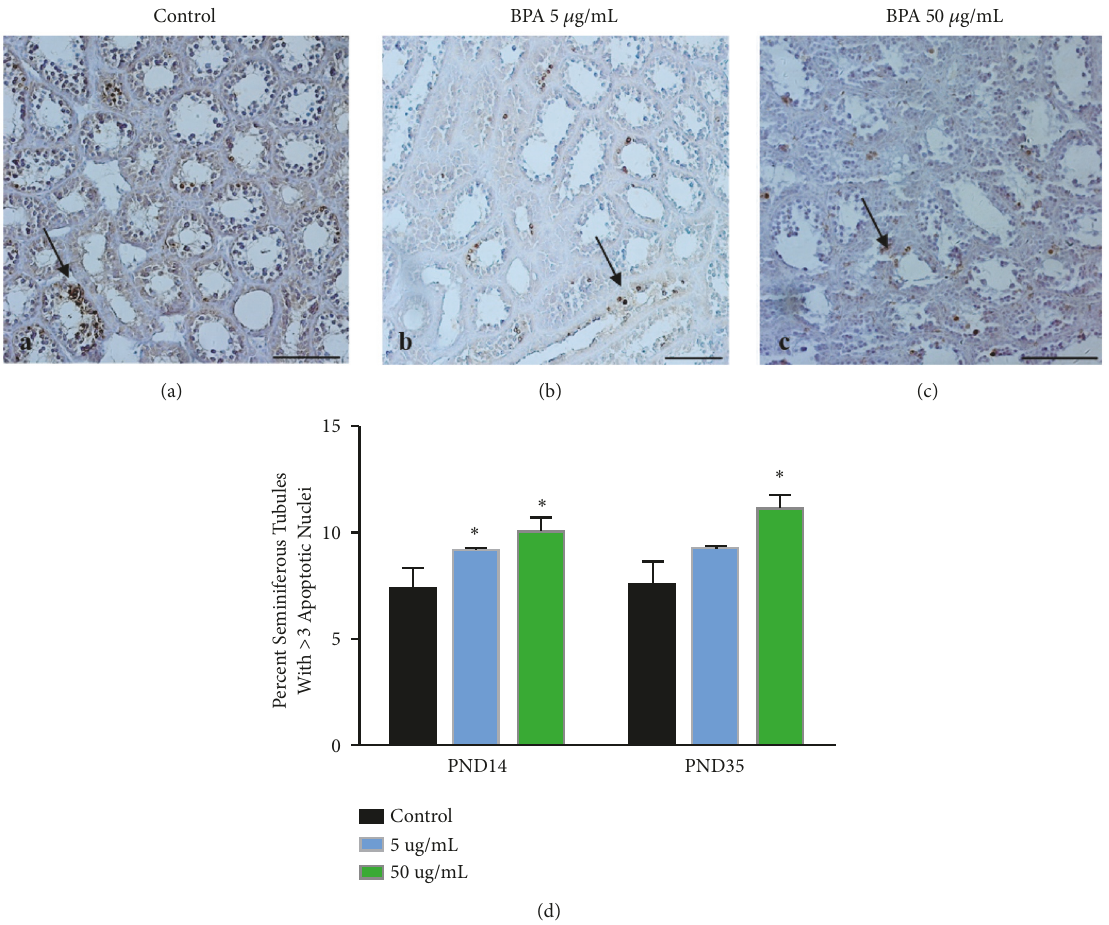
Figure 2: Germ cell apoptosis in pups from female exposure to BPA at 5 𝜇 g/mL or 50 𝜇 g/mL throughout gestation . Representative images of TUNEL staining in the testis for control (a), BPA at 5 𝜇 g/mL (b) and BPA at 50 𝜇 g/mL (c) on PND14. (d) The percentage of TUNEL-positive seminiferous tubules with greater than 3 apoptotic cells is represented as mean ± SD. N=3 per treatment group, with each n representing a different litter from a different female. The ∗ indicates a significant difference compared to control at P < 0.05. Bar = 100 𝜇